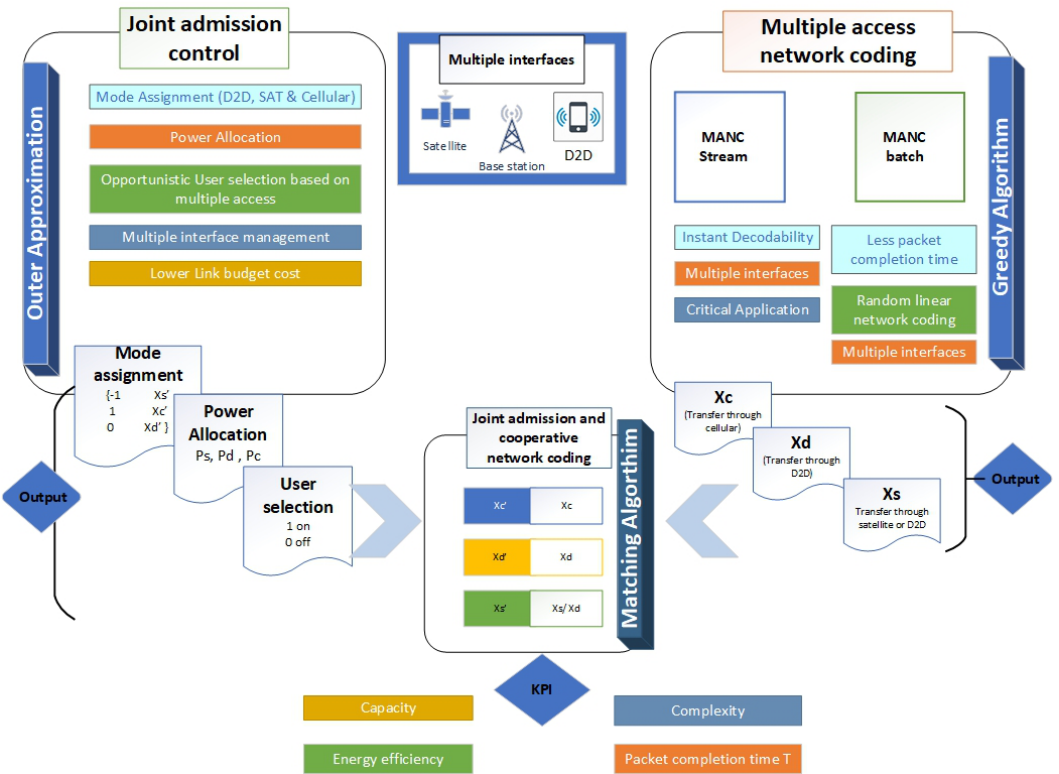
Figure 5. Workflow: Cooperative admission with network coding